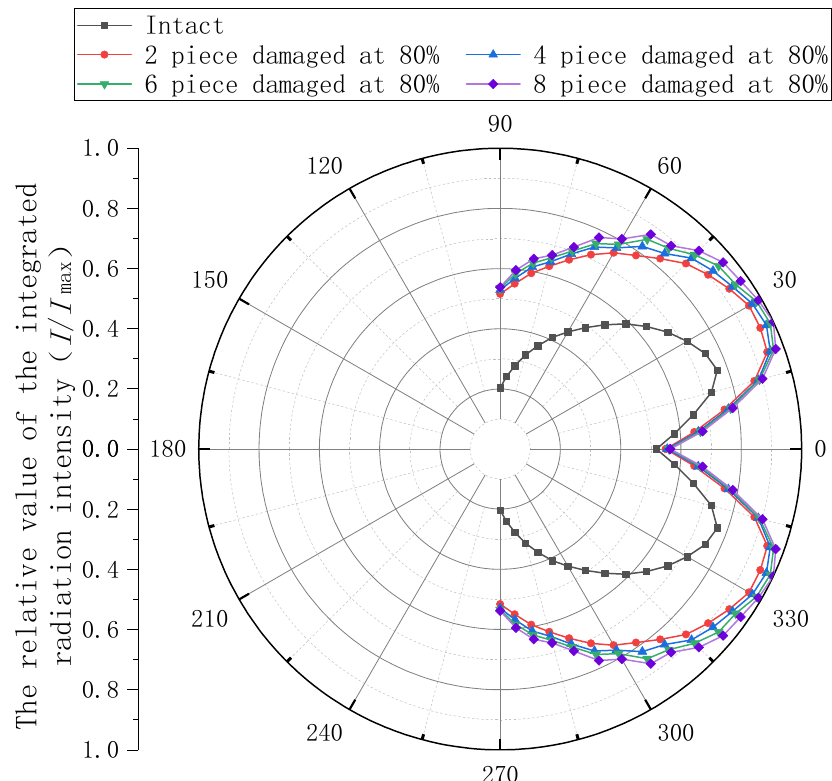
Figure 22. Angular distribution of infrared radiation intensity.